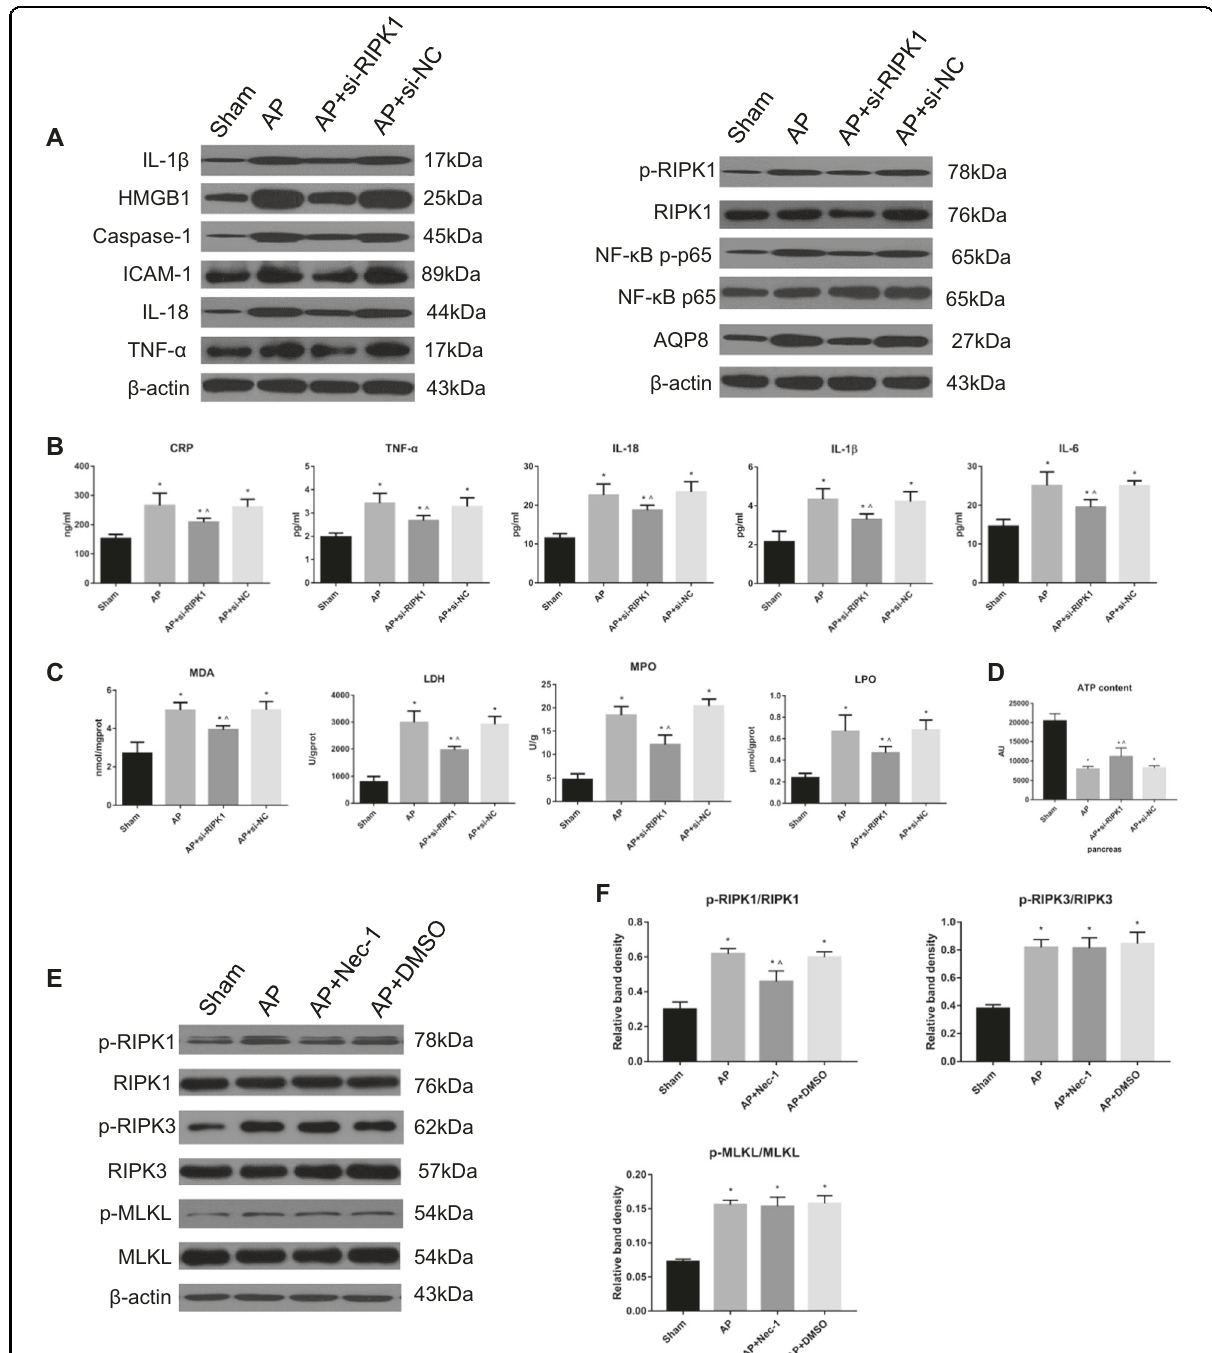
Fig. 4 Inhibition of RIPK1 did not affect the classic necroptosis pathway in AP rats. a Representative immunoblot images and b quantitation of the IL-1 β , HMGB1, Caspase-1, ICAM-1, IL-18, TNF- α , p-RIPK1/RIPK1, NF- κ B p-p65/p65, and AQP8 levels in pancreatic tissues harvested from the rats described above in Fig. 3a. β -Actin was used as the protein loading control. b The levels of CRP, TNF- α , IL-18, IL-1 β , and IL-6 in peripheral blood samples harvested from the rats described in Fig. 3a were spectrophotometrically measured. c The levels of MDA, LDH, MPO, and LPO in pancreatic tissues harvested from the rats described above in Fig. 3a were assessed spectrophotometrically. d The ATP levels in pancreatic tissues harvested from the rats in Fig. 3a were quanti fi ed. e Representative immunoblot images and f quantitation of the p-RIPK1/RIPK1, p-RIPK3/RIPK3, and p-MLKL/ MLKL ratios in pancreatic tissues harvested from the rats described in Figure 3a. β -Actin was used as the protein loading control. The data are the means ± S.Ds. ( n = 3). * P < 0.05 versus sham, ^ P < 0.05 versus